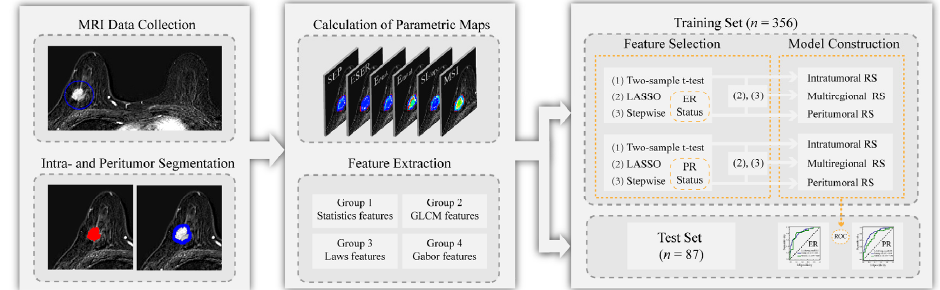
Figure 1. Flowchart of approaches used in this study.